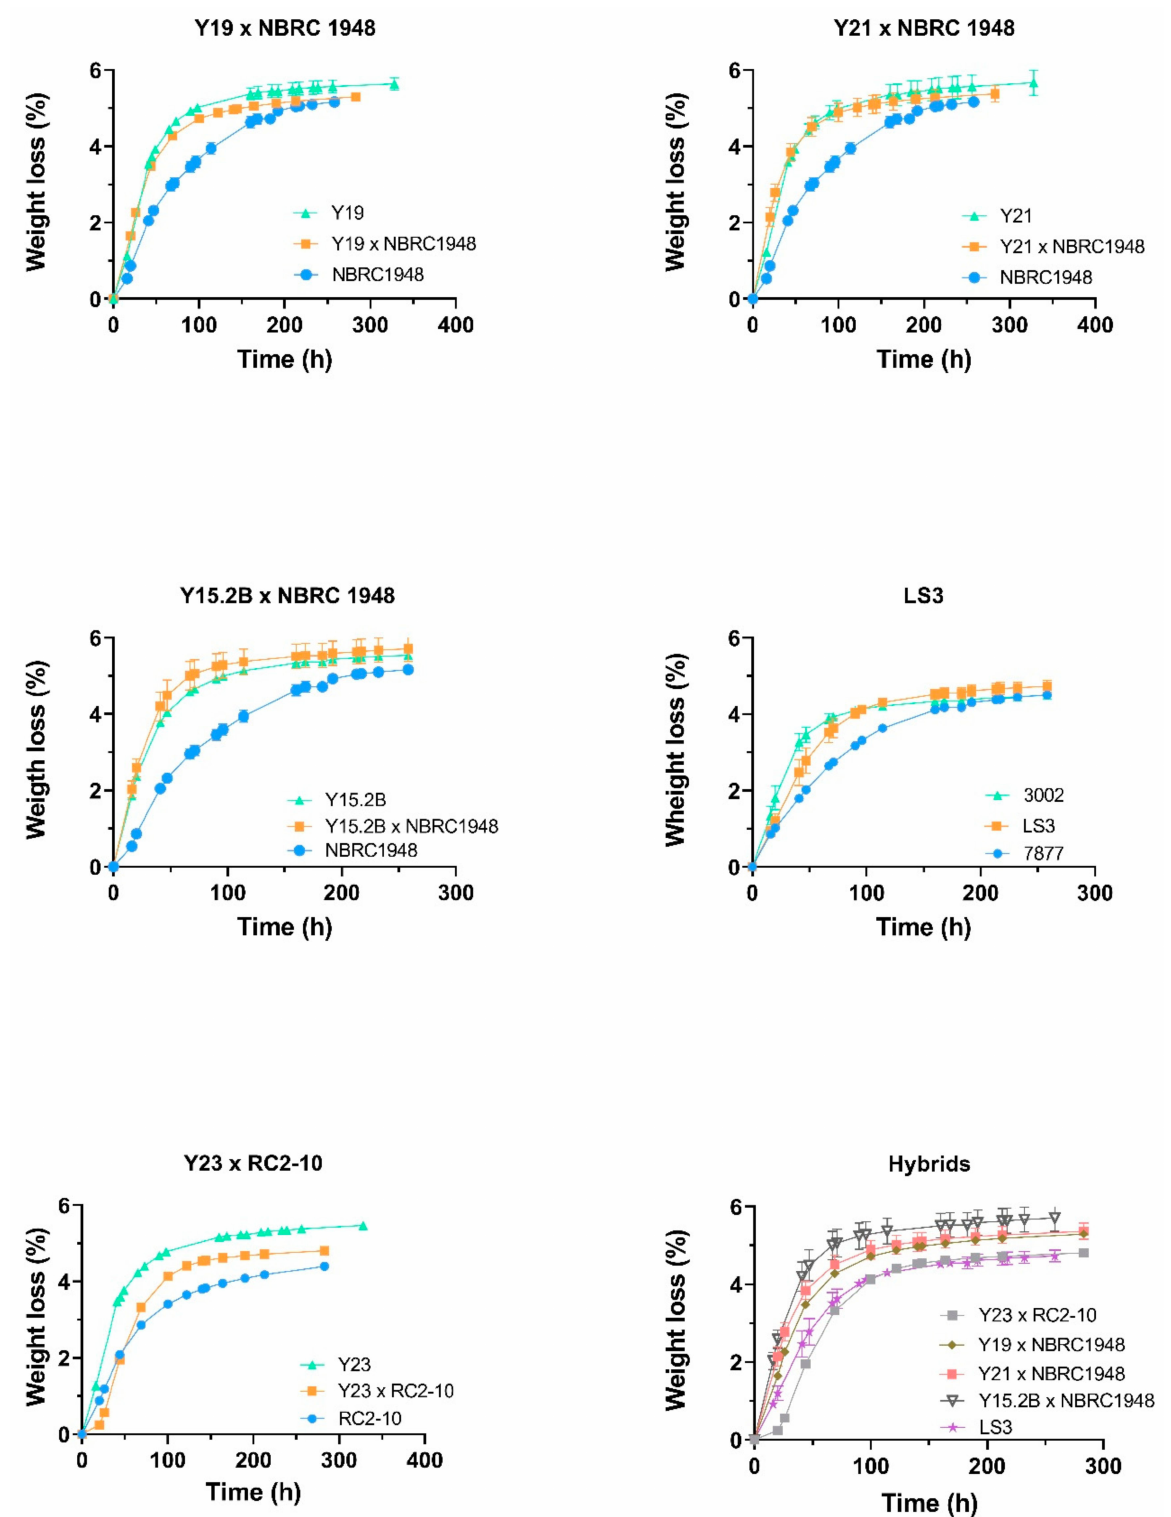
Figure 3. Growth curve plots of hybrids and their parents in wort fermentation assays at laboratory scale (15 ◦ P; 20 ◦ C). Growth kinetics were measured as weight loss percentage over time. Values are mean of three replicates. Bars represent standard